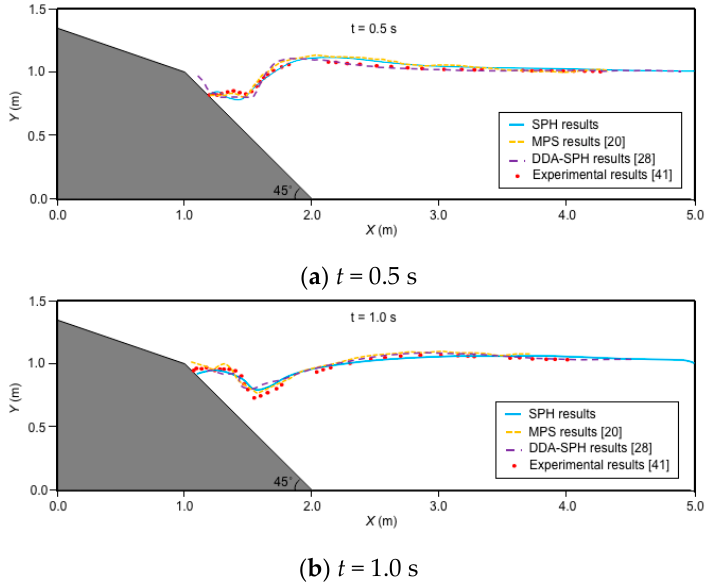
Figure 7. Comparison between the simulated and observed wave profiles at different times: ( a ) t = 0.5 s; ( b ) t = 1.0 s; ( c ) t = 1.5 s.